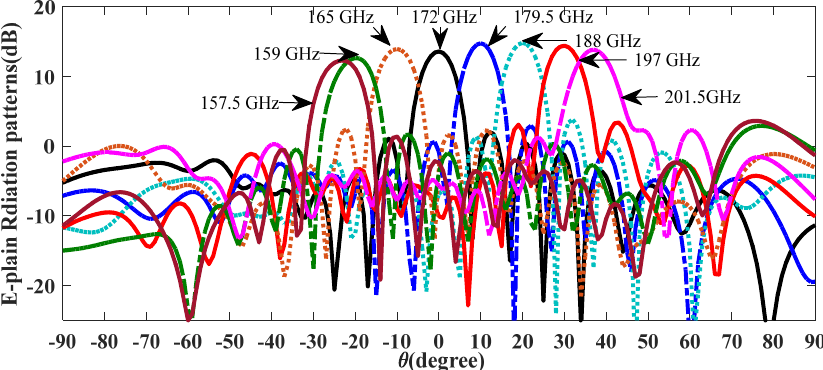
Figure 4. Simulated radiation patterns in the E-plane at different frequencies.